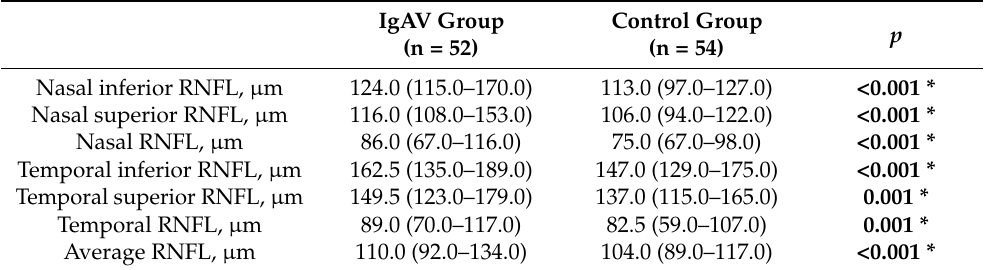
Table 3. Comparisons of Retinal Nerve Fiber Layer Thicknesses in the Right Eyes of Immunoglobulin A Vasculitis and control groups.